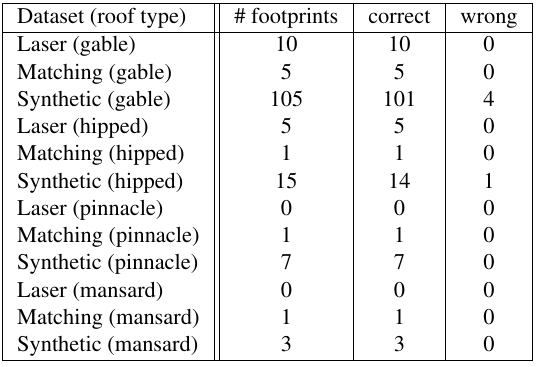
Table 1: Results of our experiments conducted on different data sets. The number of correct versus wrong fits given the